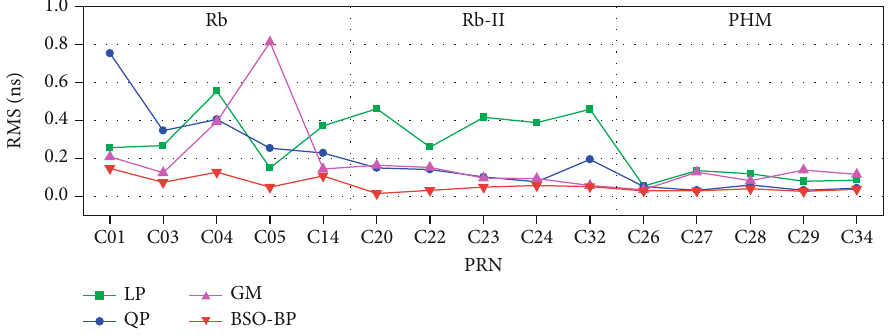
Figure 7: The prediction accuracy of 15 BDS satellites for 1 hour using 6 hours SCB